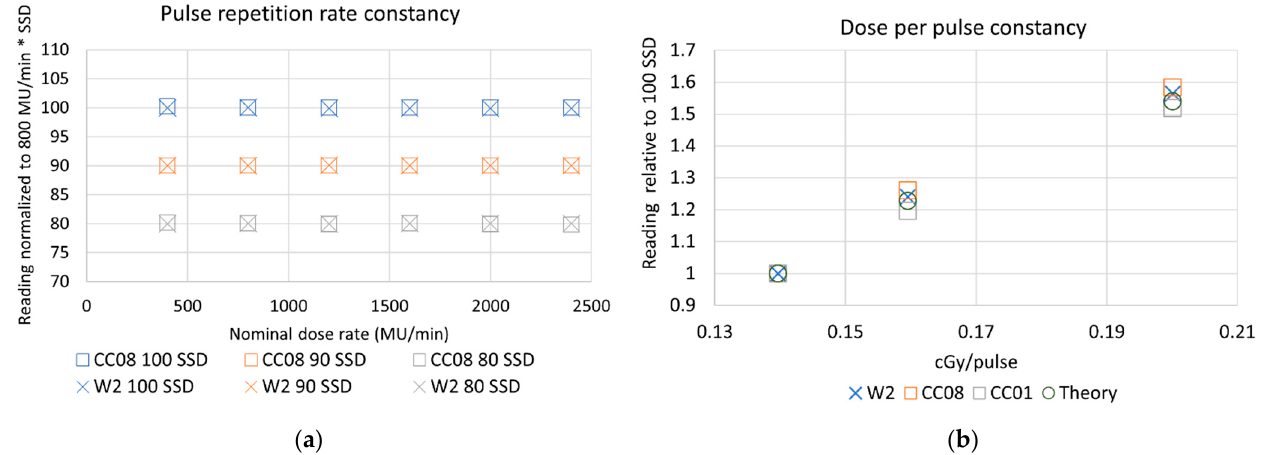
Figure 4. ( a ) Output of the CC08 ion chamber (squares) and W2 scintillator (X) is constant as a function of nominal dose rate at 100 cm SSD (blue, top row), 90 cm SSD (orange, middle row), and 80 cm SSD (gray, bottom row). Each detector’s output was normalized to the reading from the respective detector and SSD at 800 MU/min. ( b ) Detector signal as a function of DPP for the W2 scintillator, and CC08 and CC01 ion chambers, relative to the signal at 100 SSD (0.14 cGy/MU). The theoretical relationship that was expected is shown with